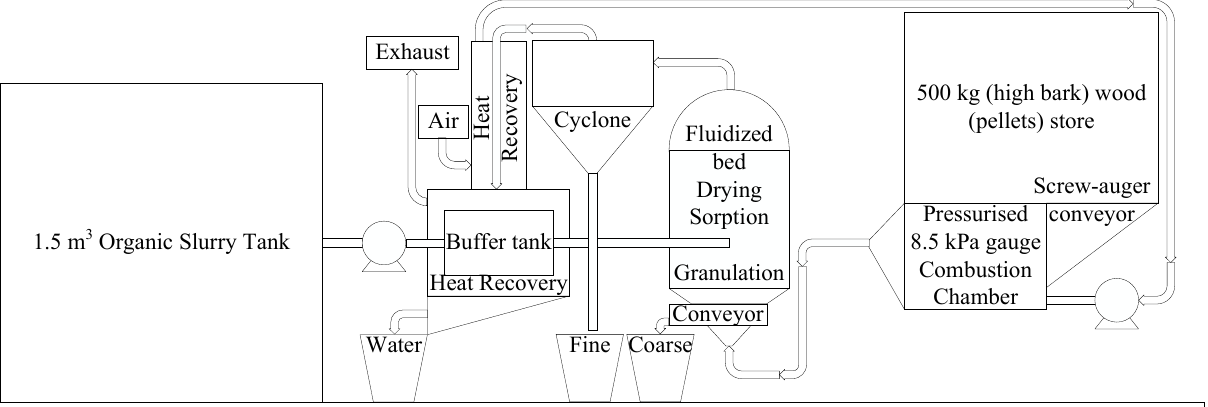
Figure 4. Modified wood pellet boiler for processing 1 tonne of fresh OS (95% moisture) in a 10 h batch operation, consuming 180 kg of wood pellets [94] . The granular organic amendment (51 kg) contains 0.03% of wood ash, in addition to the dried manure (99.97%). Inspired in the media slurry drier of Nara Machinery Ltd. [95] .